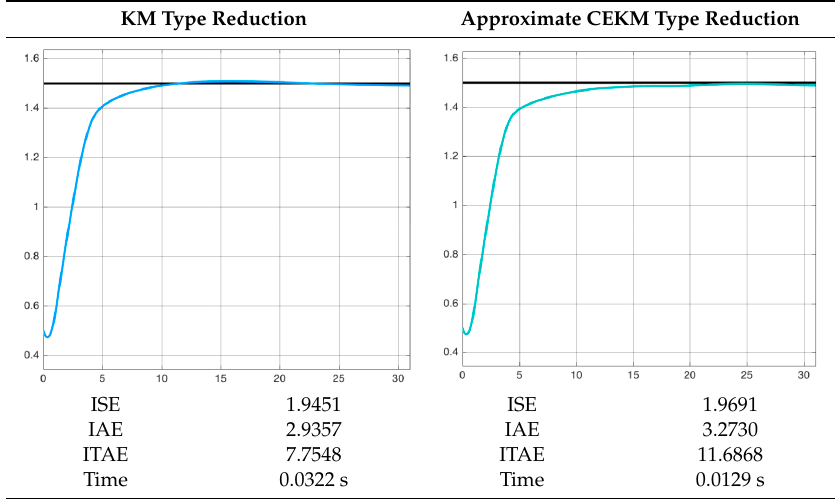
Table 9. Performance comparison.